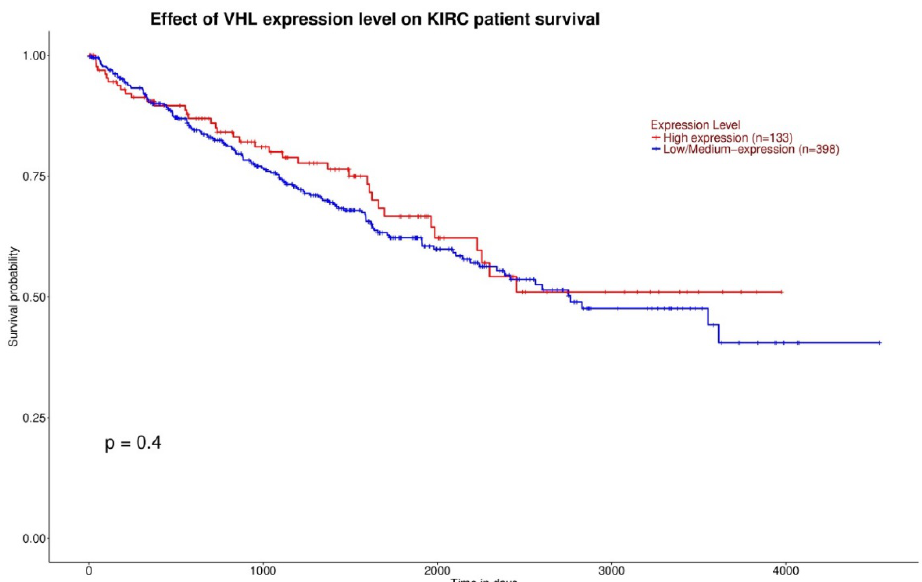
Figure 2. Box-plot analysis showing statistically significant difference ( p < 0.0001) of TTN expression between normal tissue and primary tumor.